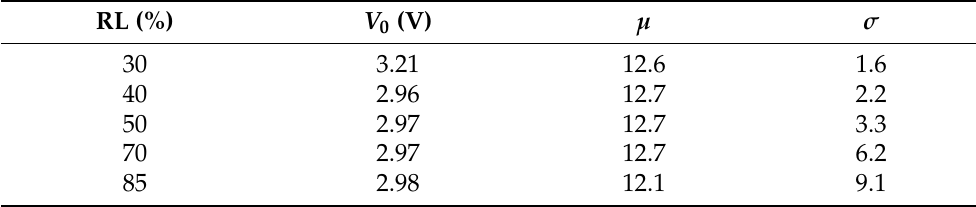
Table 6. Comparison of the output voltages, mean, and variance of the on-time for an interleaved buck converter switch 1 for different randomness levels of RCFMFD switching modulation schemes.